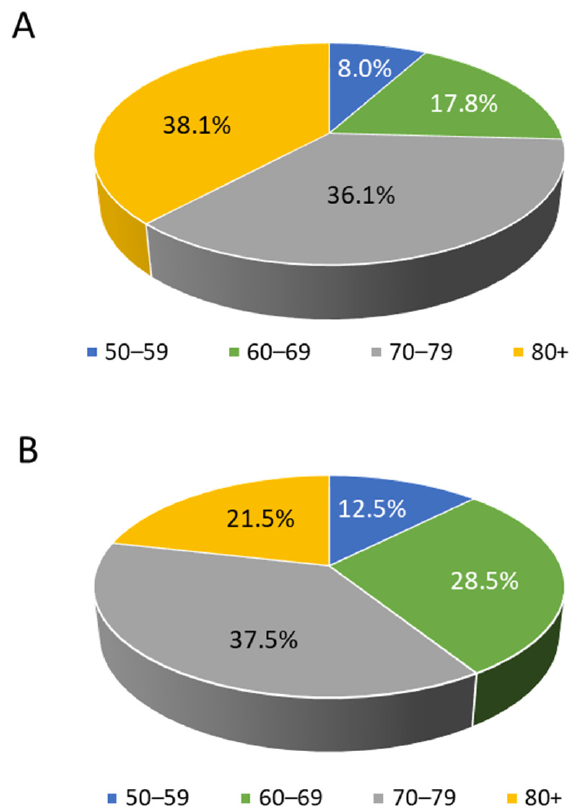
Figure 1. Age distribution among wAMD patients ( A ) and those affected by other ocular diseases ( B ). The analysis of pharmaco-utilization of three anti-VEGF molecules has shown that at the index date, 82.2% of wAMD patients were under Ranibizumab treatment, 15.8% were treated with Aflibercept, and 2% with Pegaptanib as monotherapy (Table 2). Table 2. Use of anti-VEGF drugs at index date among wAMD patients and those affected by other ocular diseases.